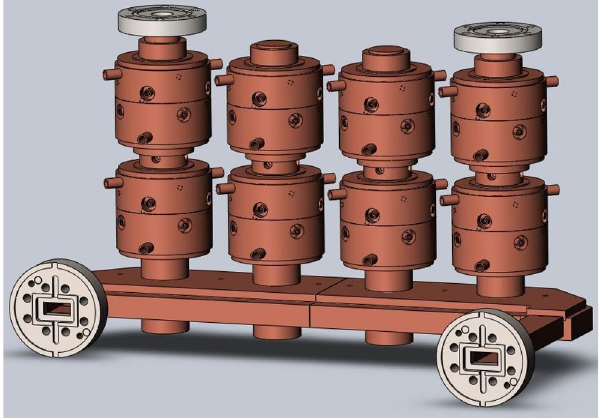
FIG. 1. The mechanical design of the CC.